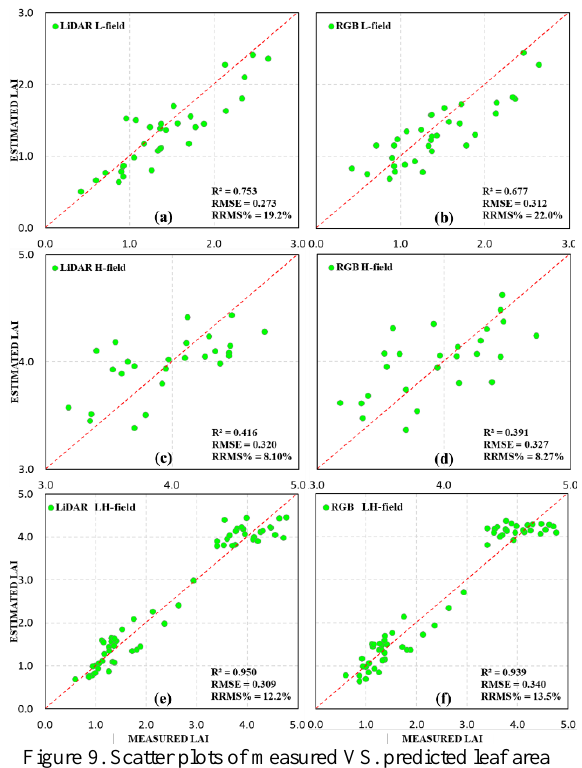
Figure 9. Scatter plots of measured VS. predicted leaf area index (LAI) for L-field using LiDAR (a) and RGB photogrammetry (b), and H-field using LiDAR (c) and RGB photogrammetry (d), as well as LH-field using LiDAR (e) and RGB photogrammetry (f).